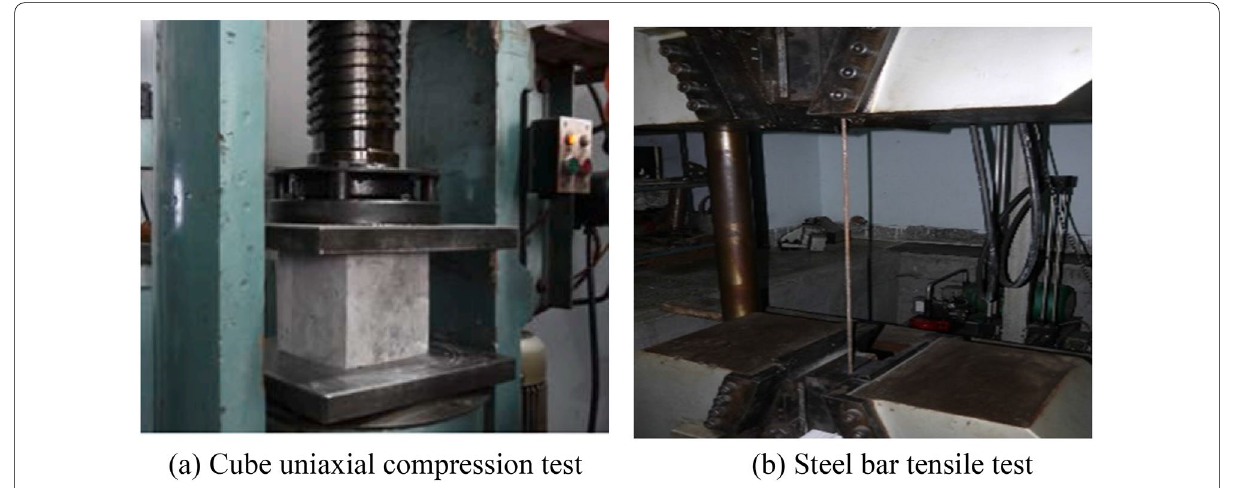
Fig. 4 Concrete and steel bar material